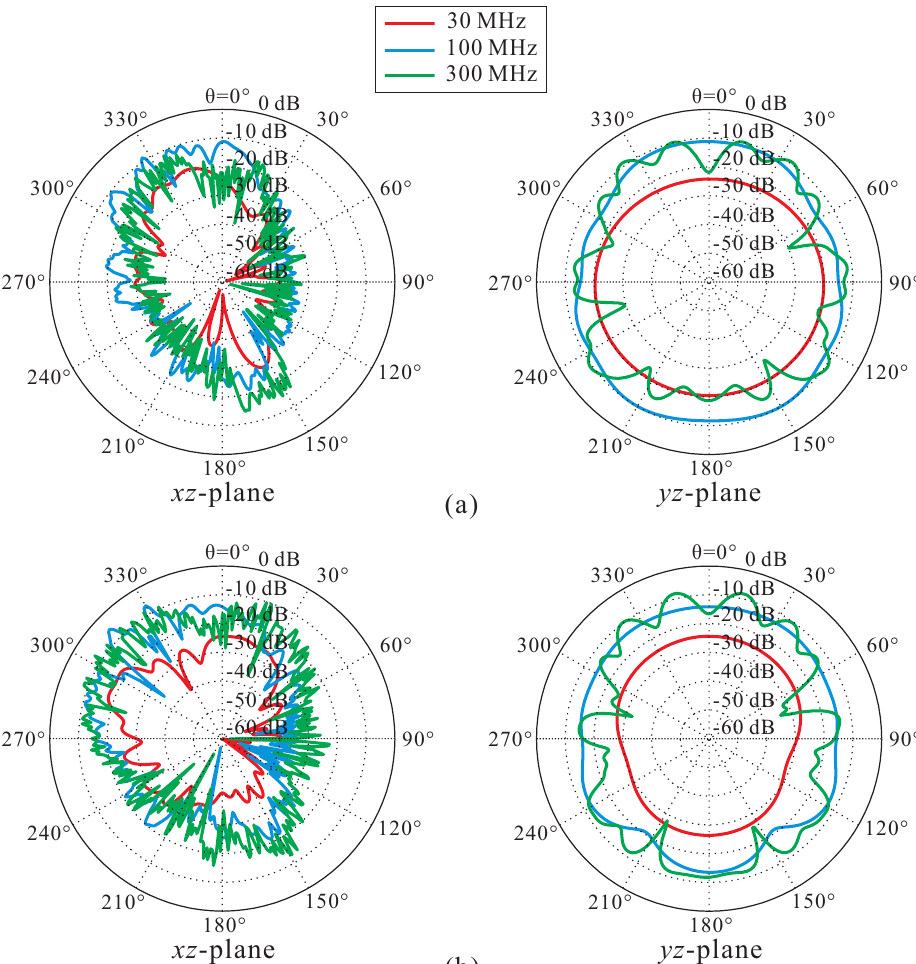
Figure 10. Simulated radiation patterns of the proposed antenna mounted on the integrated mast of an OPV at 30, 100, and 300 MHz: ( a ) x -axis; ( b ) y